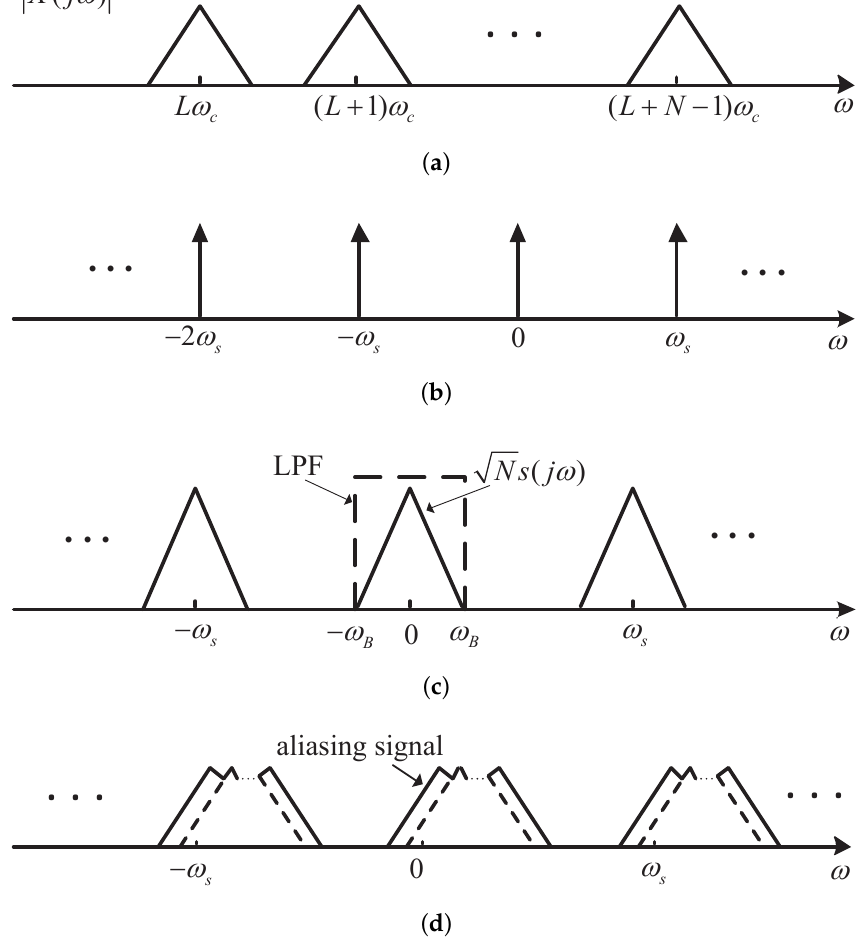
Figure 2. Frequency domain representation of proposed sampling method. ( a ) Spectrum of x ( t ) . ( b ) Spectrum of sampling function. ( c ) Spectrum of sampled signal with f s = f c . ( d ) Spectrum of sampled signal with f s (cid:54) = f c